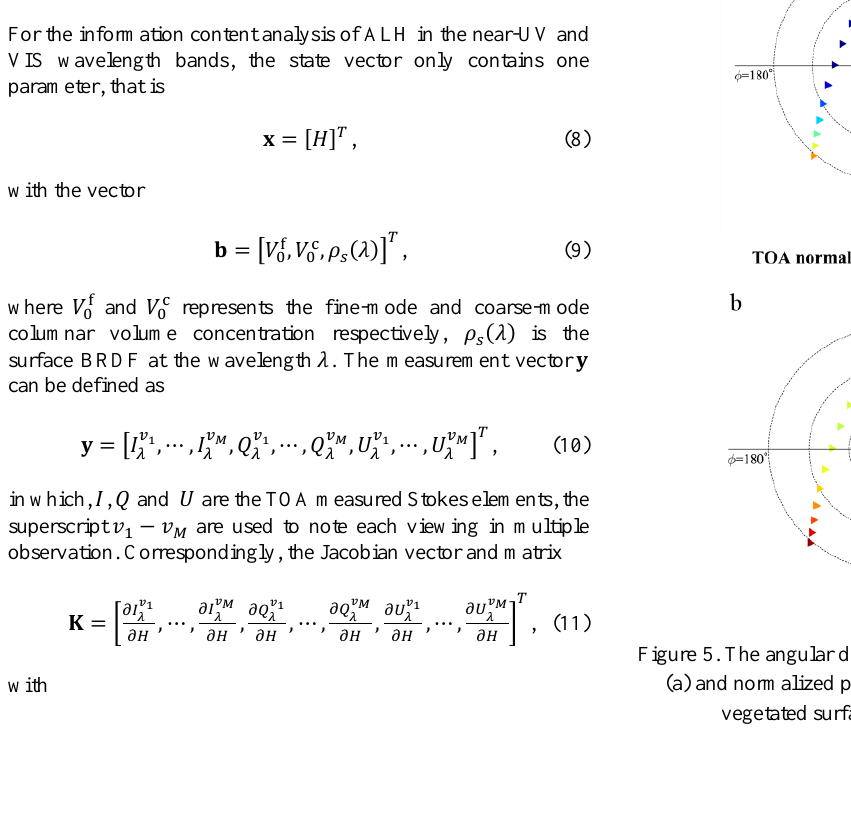
Figure 4. The angular distribution of BRDF results in 410 nm (a) and the angular distribution of wavelength-independent BPDF results (b) with each colour bar for vegetated surface.